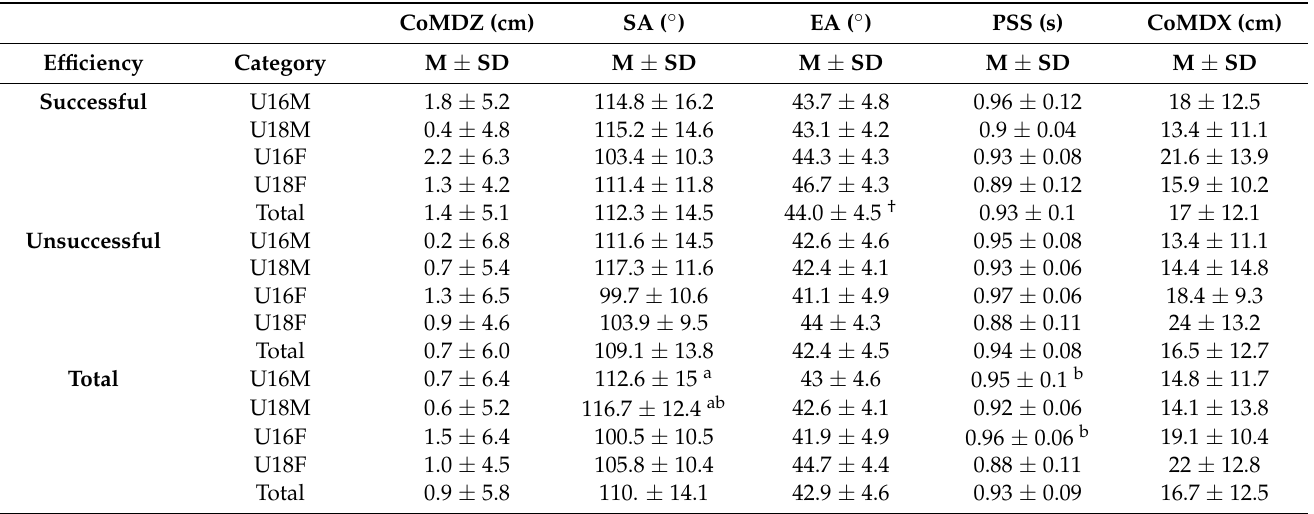
Table 2. Descriptive statistics of selected kinematic variables for 3pt shooting according to efficiency and category.